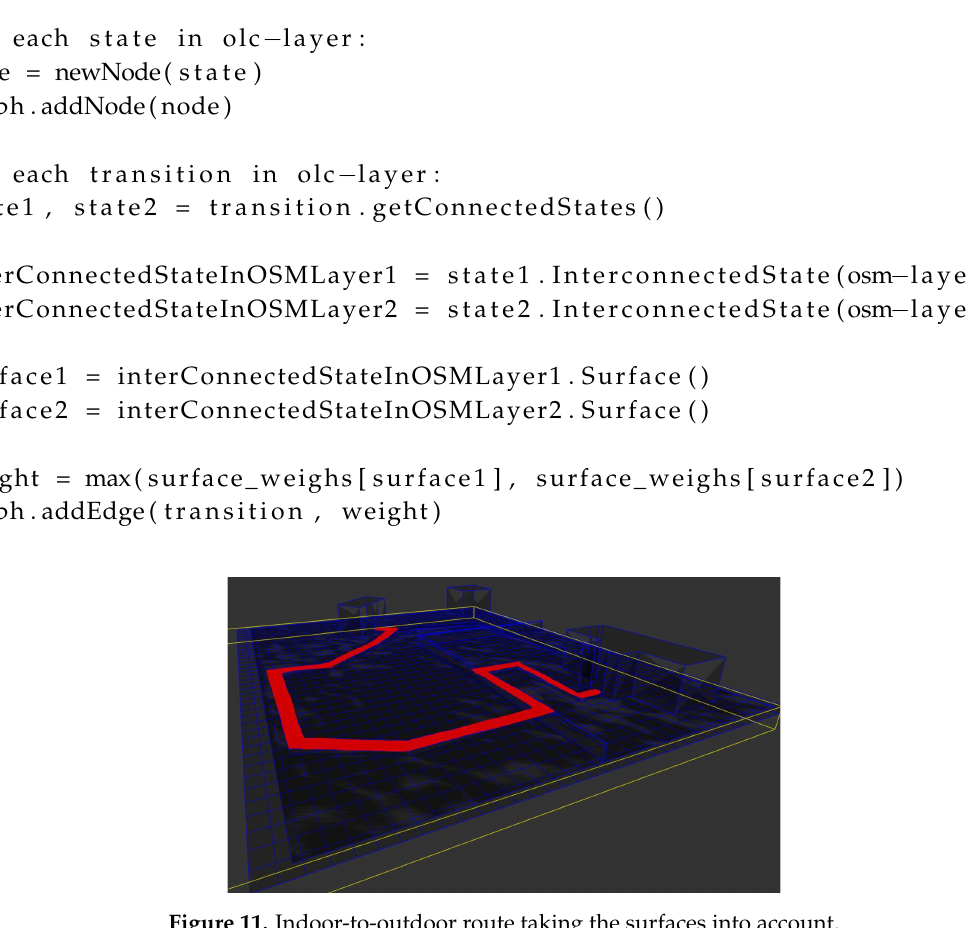
Figure 11. Indoor-to-outdoor route taking the surfaces into